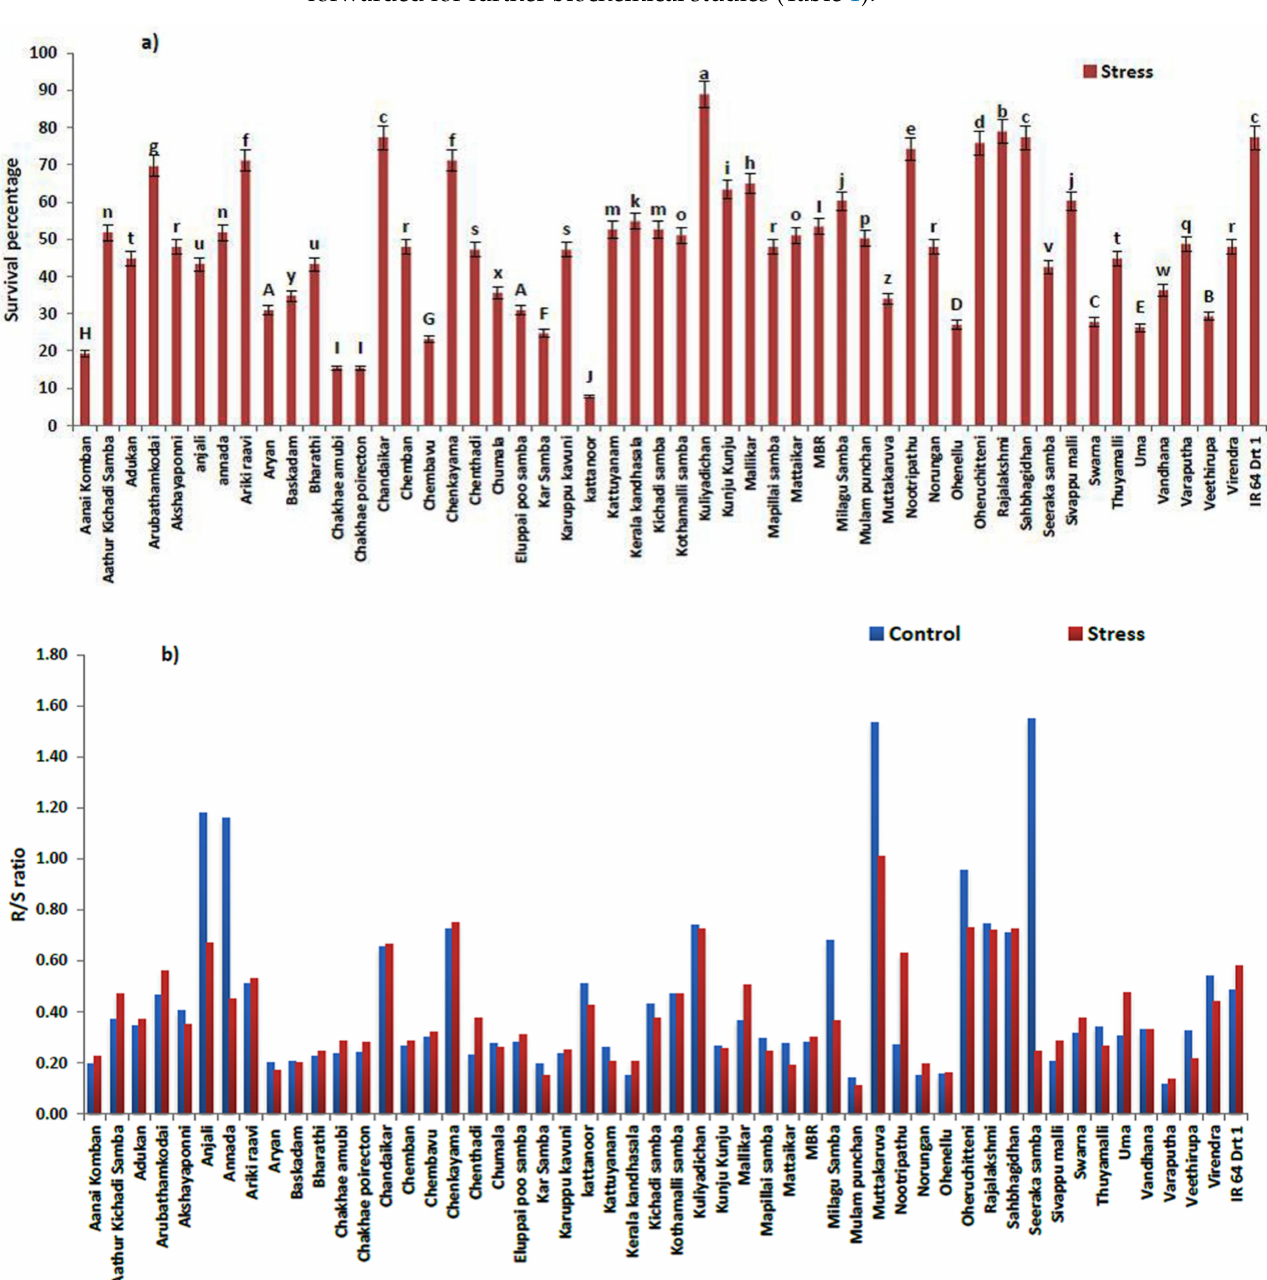
Figure 1. ( a ) Survival percent. ( b ) R/S ratio of rice genotypes under moisture stress ( − 1.5 MPa). Data represented are mean ( ± standard error) ( n = 3), and values followed by the same lowercase letter are not significantly different from each other, as determined by DMRT ( p ≤ 0.05). IR 64 and IR 64 Drt1 used as negative and positive checks,